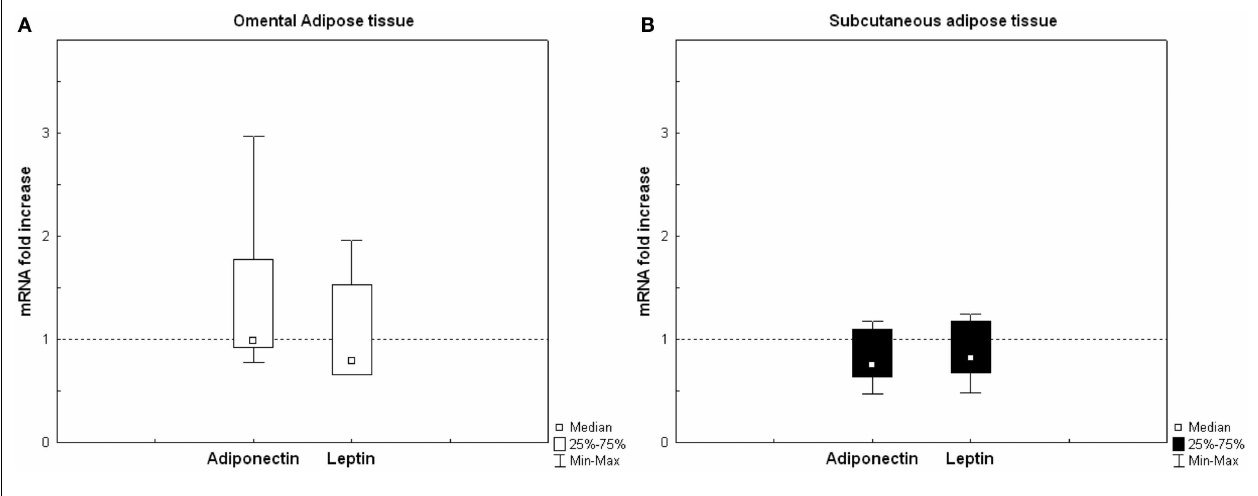
gene cyclophilin A, using the first biopsy in every paired analysis as a reference (dotted line = no change). Omental AT ( n = 7) and subcutaneous AT ( n = 8).There were no differences in gene expression of adiponectin or leptin in neither omental, nor subcutaneous AT usingWilcoxon signed-rank